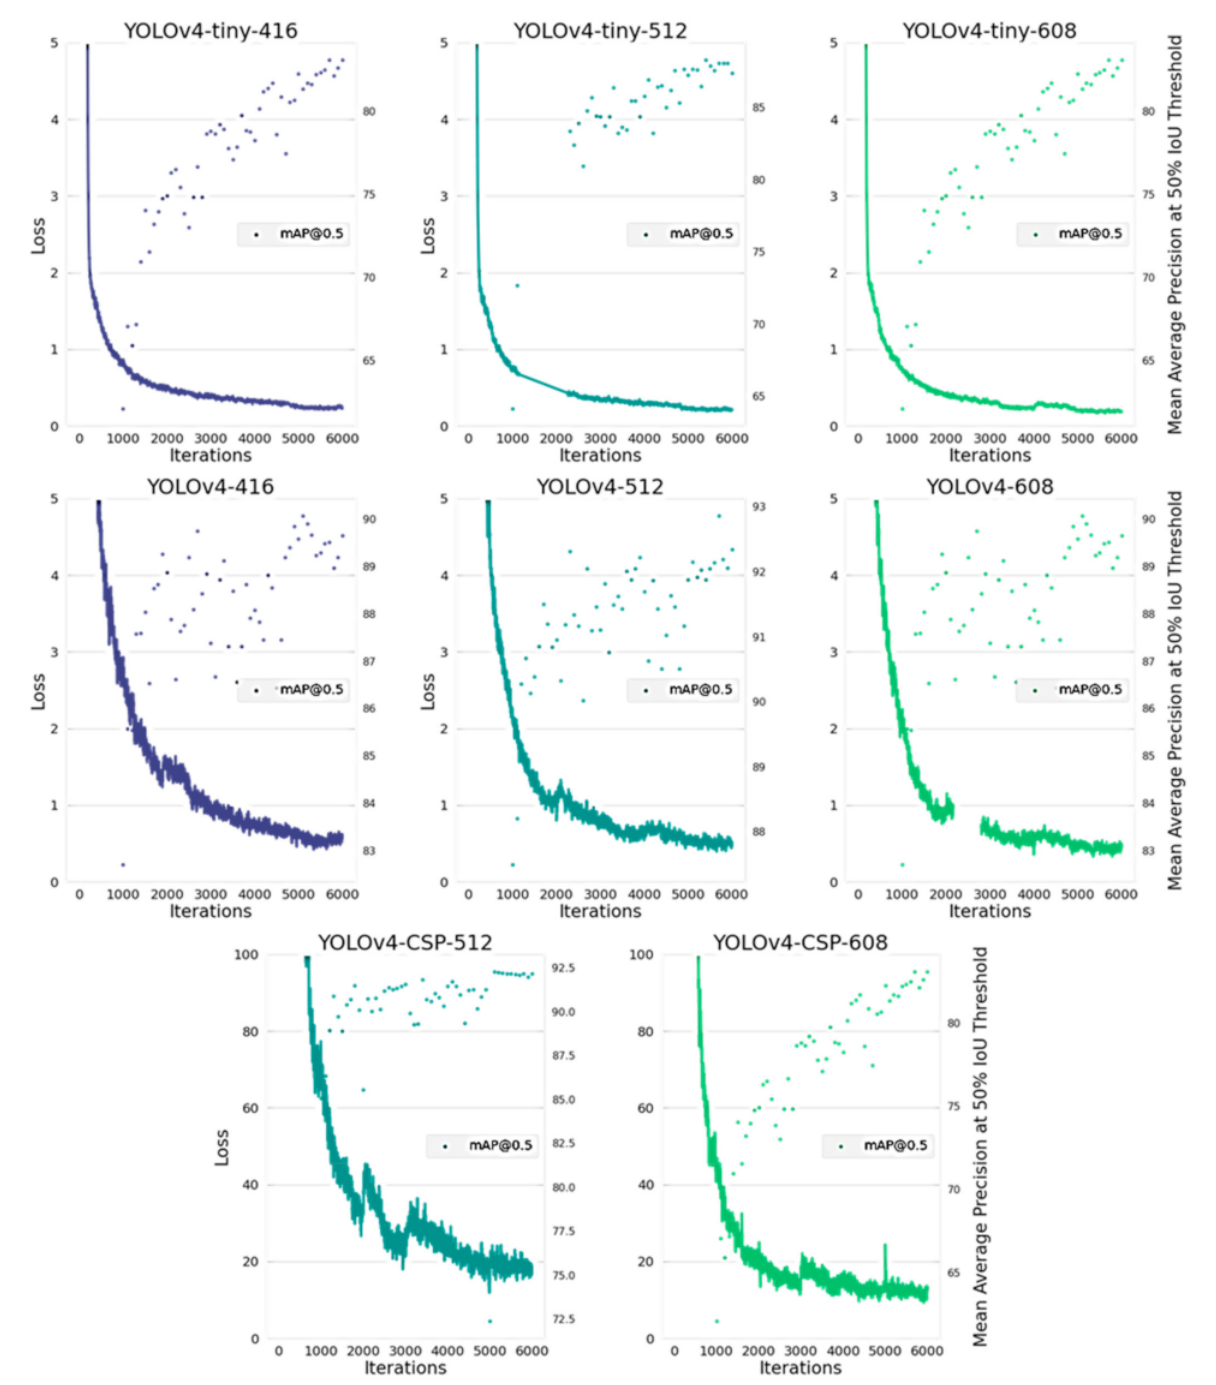
Figure 13. Average Loss and Mean Average Precision (mAP) over 6000 iterations for each of the YOLOv4